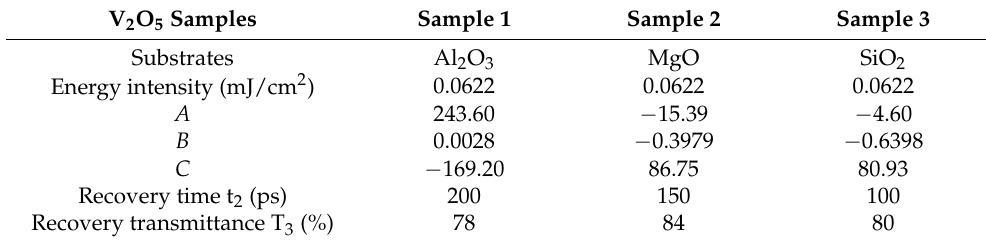
Table 2. Fit parameters A , B, and C for Equation (1) and recovery